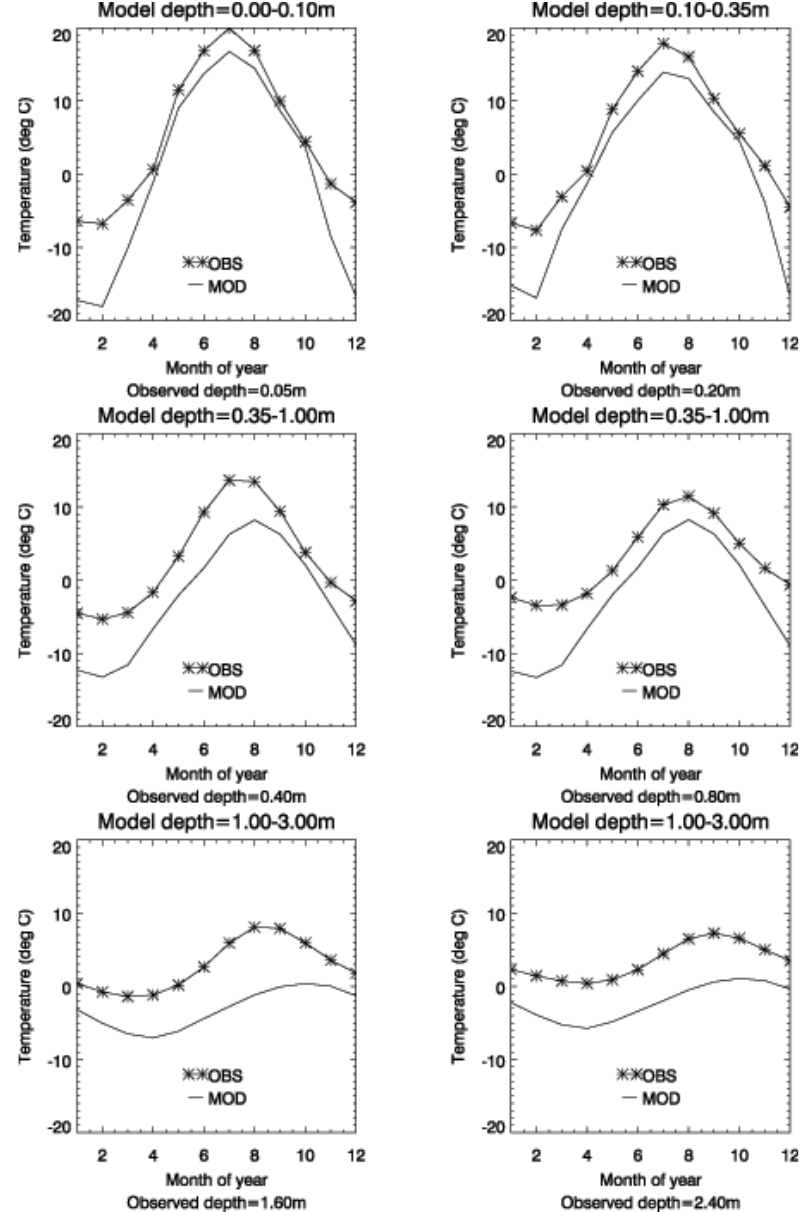
Fig. 4. As Fig. 3 but averaged over all months and stations to show the mean annual